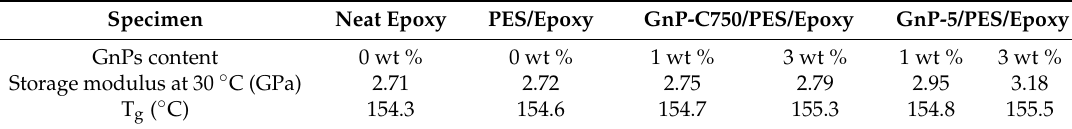
Figure 8. Dynamic mechanical properties of epoxy-based composites. Table 2. Storage modulus and T g of the epoxy-based composites